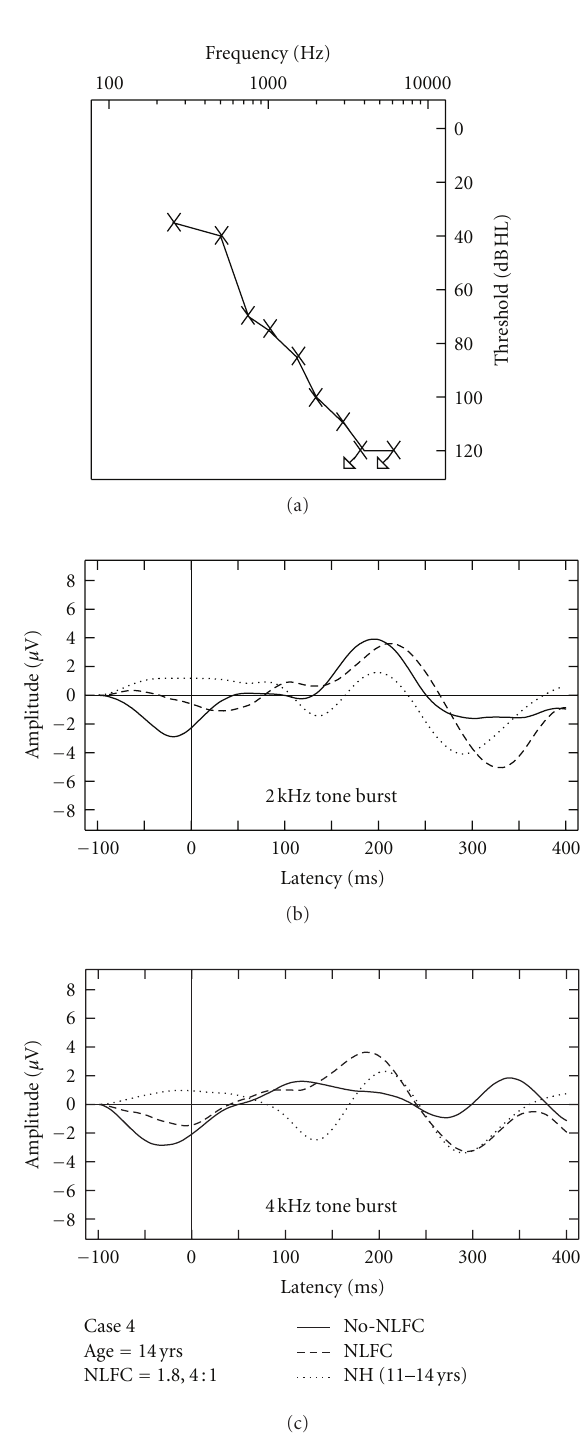
Figure 6: Case-specific grand mean CAEPs displayed across stimulus types and hearing aid conditions: no-NLFC (solid line), NLFC active (dashed line), and for each participant’s age-matched NH group (dotted line). Participant age and prescribed NLFC settings (cut-o ff frequency, compression ratio) are indicated in the legend. The top left corner pane displays test ear hearing thresholds, suspected cochlear dead regions (DR), and responses beyond the audiometric test